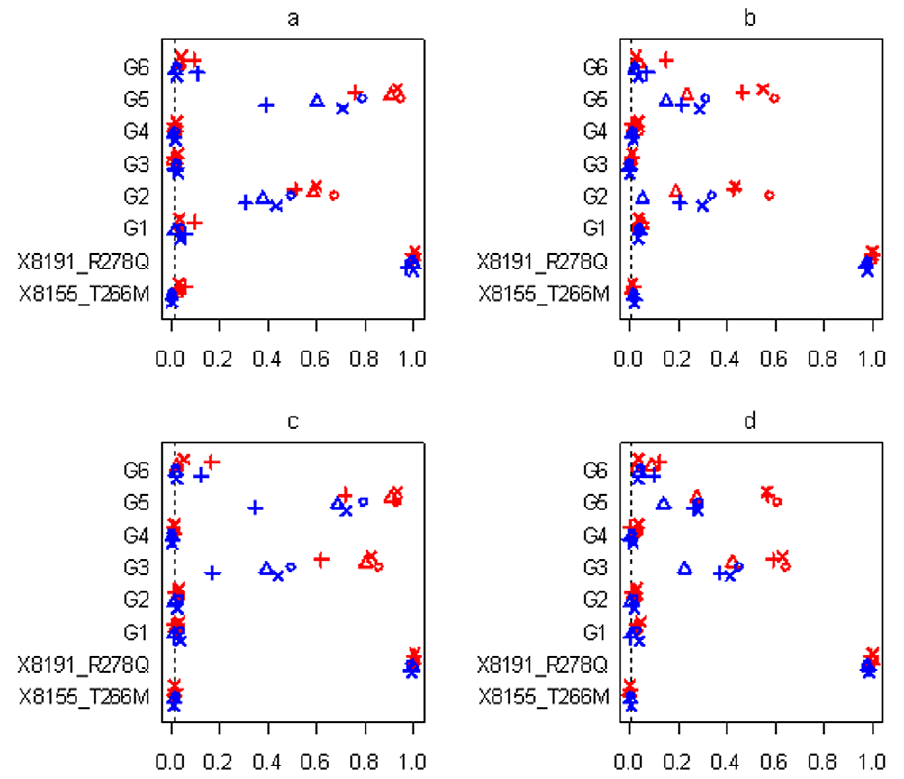
Figure 9. Simulations with sample size n=3,008 and six groups for the four scenarios (see Table 2). Power or Type I error rate for the proposed method ( # ), Yi and Zhi ( 6 ), Simple-Sum ( D ) and All-Variants ( + ) under the threshold level of 0.01. X8155_T266M and X8191_R278Q are the two common non-synonymous variants, and G1–G6 are the six group effects. Red and blue symbols represent results for continuous and binary traits, respectively. The dashed line is the nominal 0.01 level.